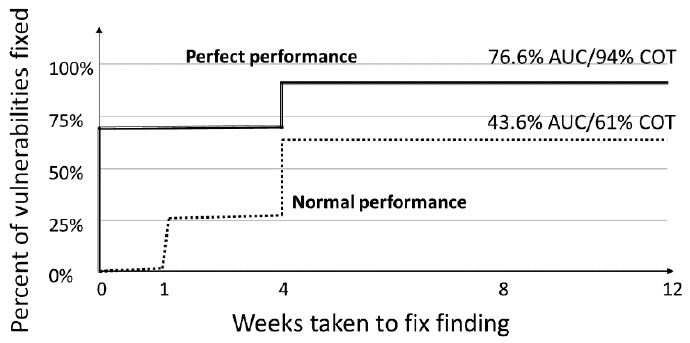
Figure 3. The performance of vulnerability fixing in a typical system. Table 1. Defense parameters of di ff erent